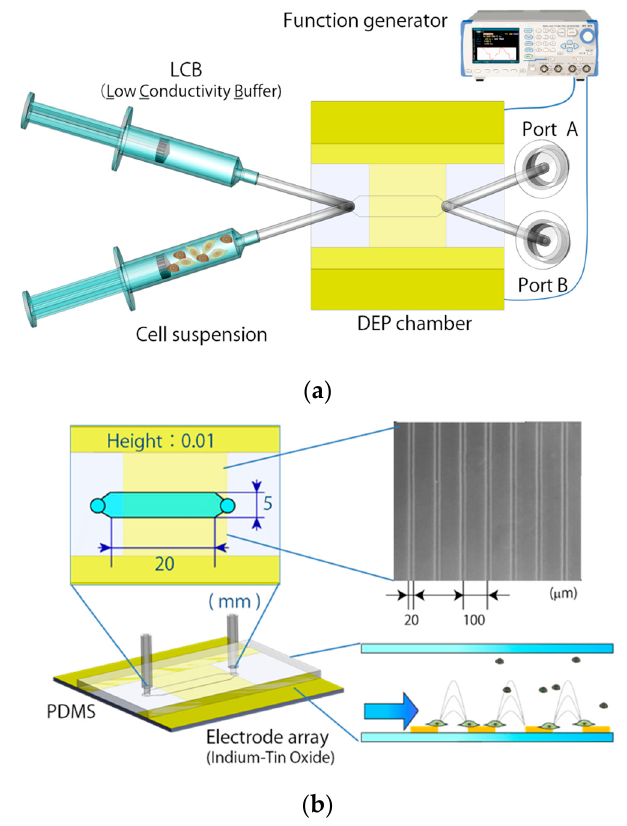
Figure 2. ( a ) Experimental setup for the DEP cell-sorting system combined with the fluid-control system; ( b ) Flow channel of the dielectrophoretic chamber and electrode array.